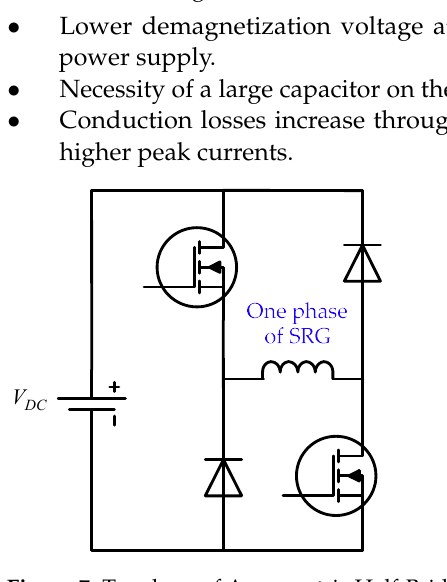
Figure 7. Topology of Asymmetric Half-Bridge Converter (AHBC).